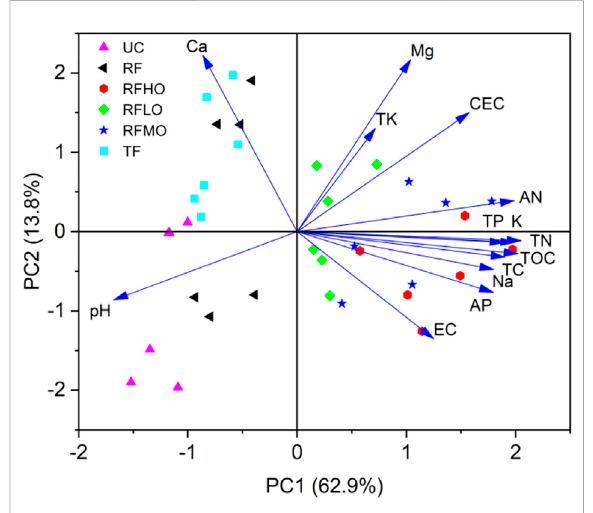
FIGURE 3 Feeding activities (%) in the six fertilization management practices were determined by the bait-lamina test ( n = 150 bait laminae) after 15 days of exposure in September 2019, and 2020. The data are median values, and the vertical bars represent SDs. Columns marked by different letters indicate signi fi cant differences at p <